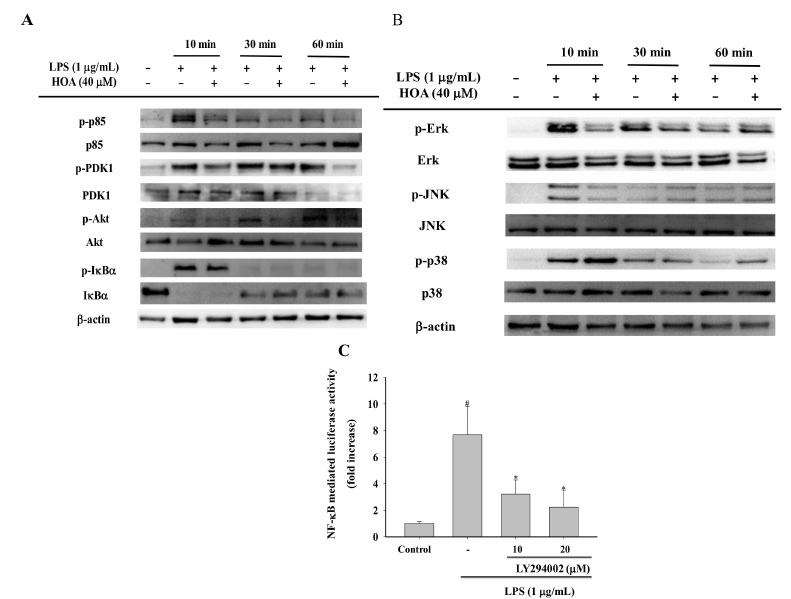
Figure 6. Effects of HOA on LPS-induced activation of PI3K/Akt and MAPKs signaling pathways. ( A ) Cells were plated at a density of 5 × 10 6 cells/dish in 60-mm culture dishes and treated with LPS and HOA for indicated time points. After preparation of the total protein, the phosphorylated and total forms of PDK1, p85, and Akt were measured by western blot. ( B ) Cells were plated at a density of 5 × 10 6 cells/dish in 60-mm culture dishes and treated with LPS and HOA for indicated time points. After preparation of the total protein, the phosphorylated and total forms of ERK, JNK, and p38 were measured by western blot. ( C ) Inhibitory effects of LY294002 on LPS-induced NF- κ B-luc activity in RAW264.7 cells. Results are representative of three experiments. * indicates a significant difference between LPS group and LY294002 + LPS groups ( p < 0.05). # indicates a significant difference